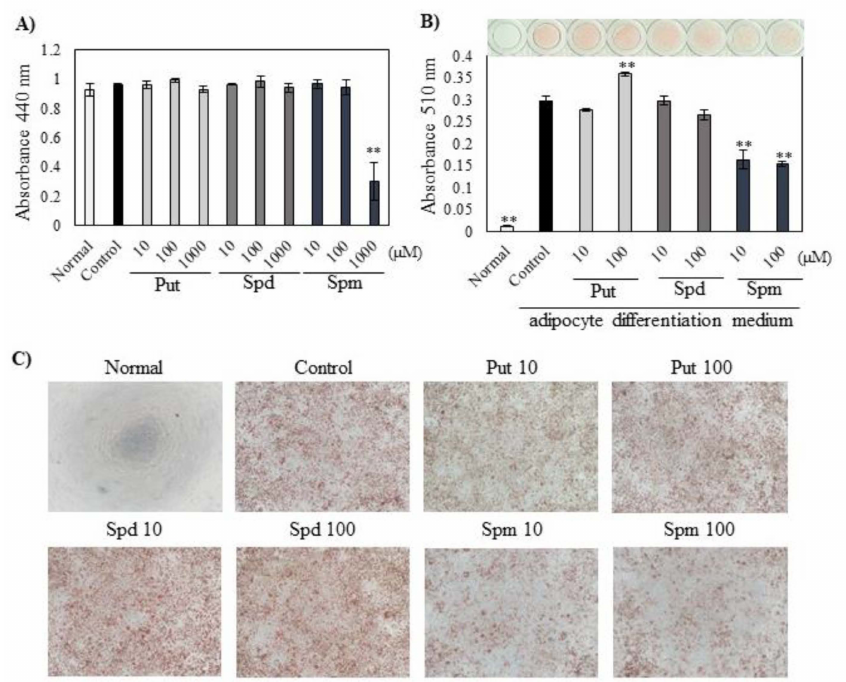
Figure 1. Effect of polyamines on ( A ) cell viability ( B , C ) lipid accumulation in 3T3-L1 adipocytes. ( A ) In the cell viability experiment, 1 mM aminoguanidine alone was used as a control without adding polyamine. ( B ) Red-stained lipid droplets by oil red O staining were dissolved, and the absorbance was measured. ( C ) Images of treated cells obtained using an inverted microscope ( × 40). Red spots in images represent areas stained by Oil Red O. Data are presented as means ± S.E. derived from three independent experiments; each experiment carried out in 3 or 4 culture wells. Dunnett’s test, ** p < 0.01 vs.